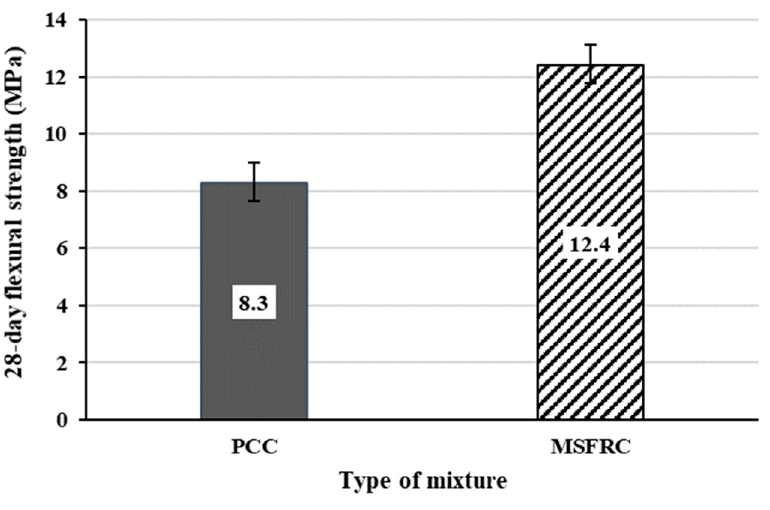
Figure 9. Flexural strength test results.